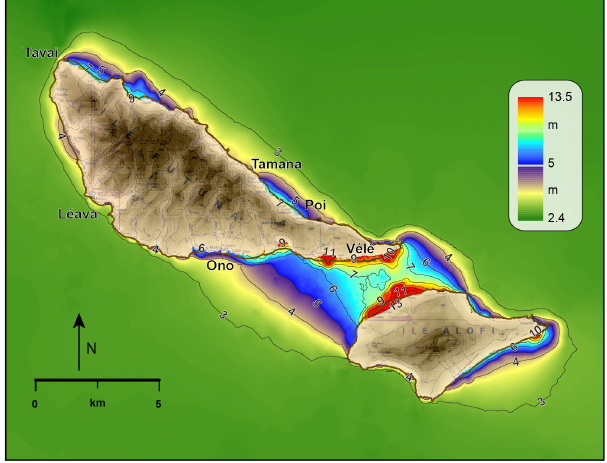
Figure 12. Maximum wave elevation (in m) at Futuna and Alofi generated by a M W = 9.1 earthquake along the Tonga Trench.